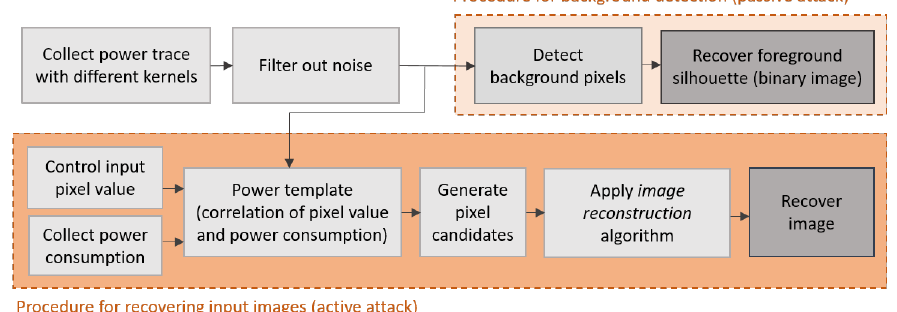
Figure 6. Overview of the attack proposed by Wei et al. [19] (artwork